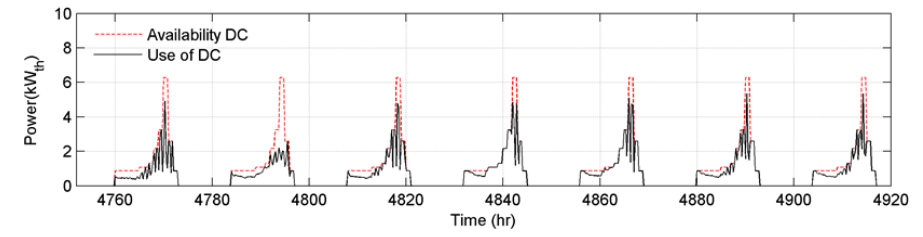
Figure 9. Energy sources used to cover the weekly cooling demand of the building compared to the availability profiles with RBC: ( a ) DC; ( b ) PV.